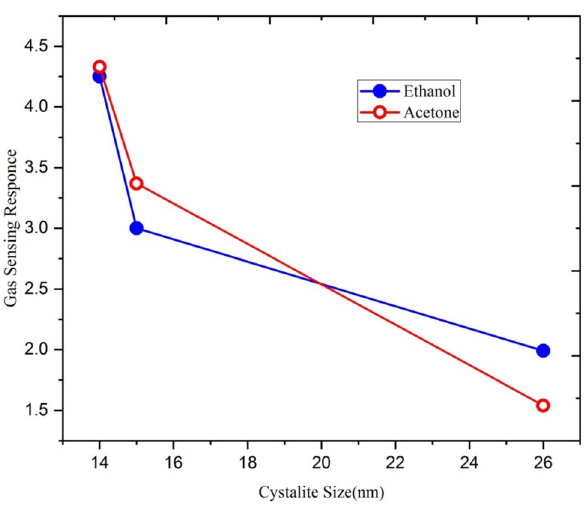
Figure 13. Variation of ethanol and acetone gas sensing response with crystallite size.